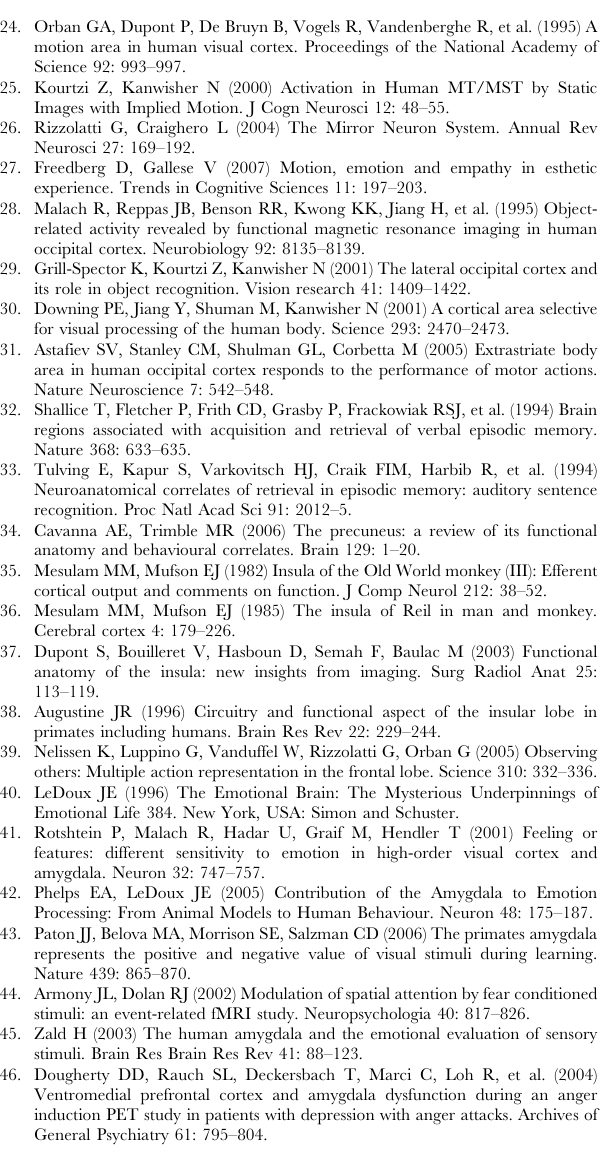
Figure S1 Deactivation pattern of judged-as-ugly sculpture images. Statistical parametric maps rendered onto the MNI brain template showing activity in the contrast ‘‘rest vs. judged-as-ugly stimuli’’ across conditions (O, AJ,